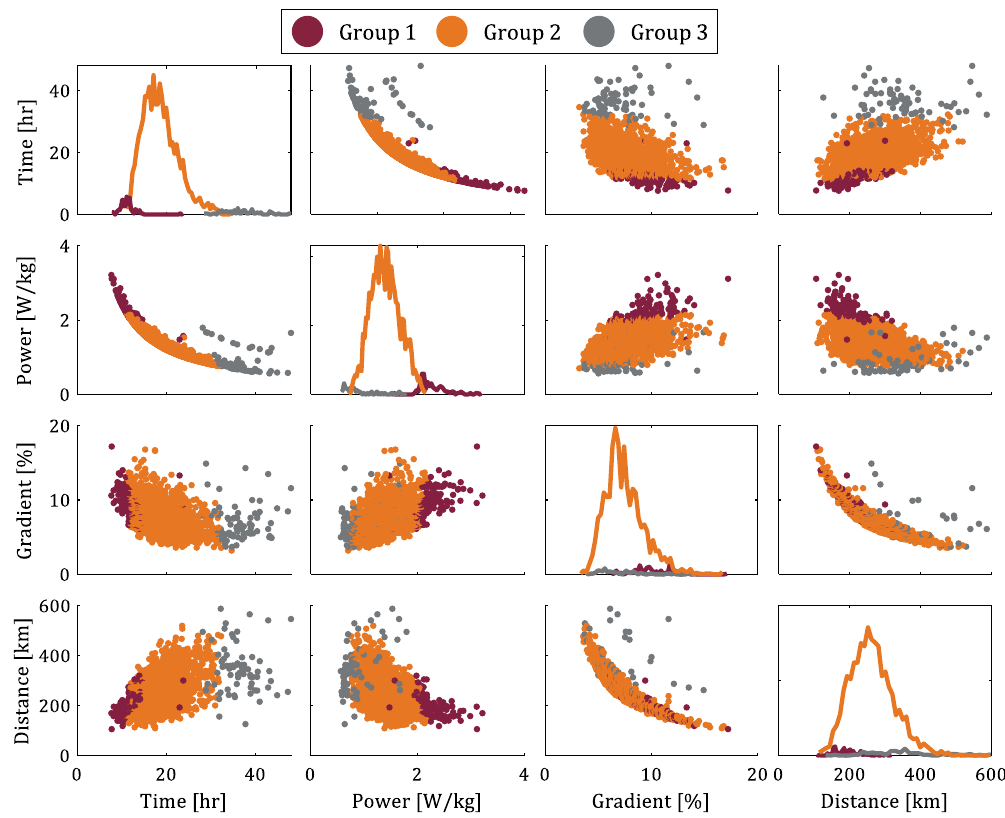
Figure 5. Pairwise relationship between input and target attributes in matrix format with the probability density function of each attribute along the main diagonal, and indicating different clusters of cyclists (groups 1, 2, and 3) based on a Gaussian mixture